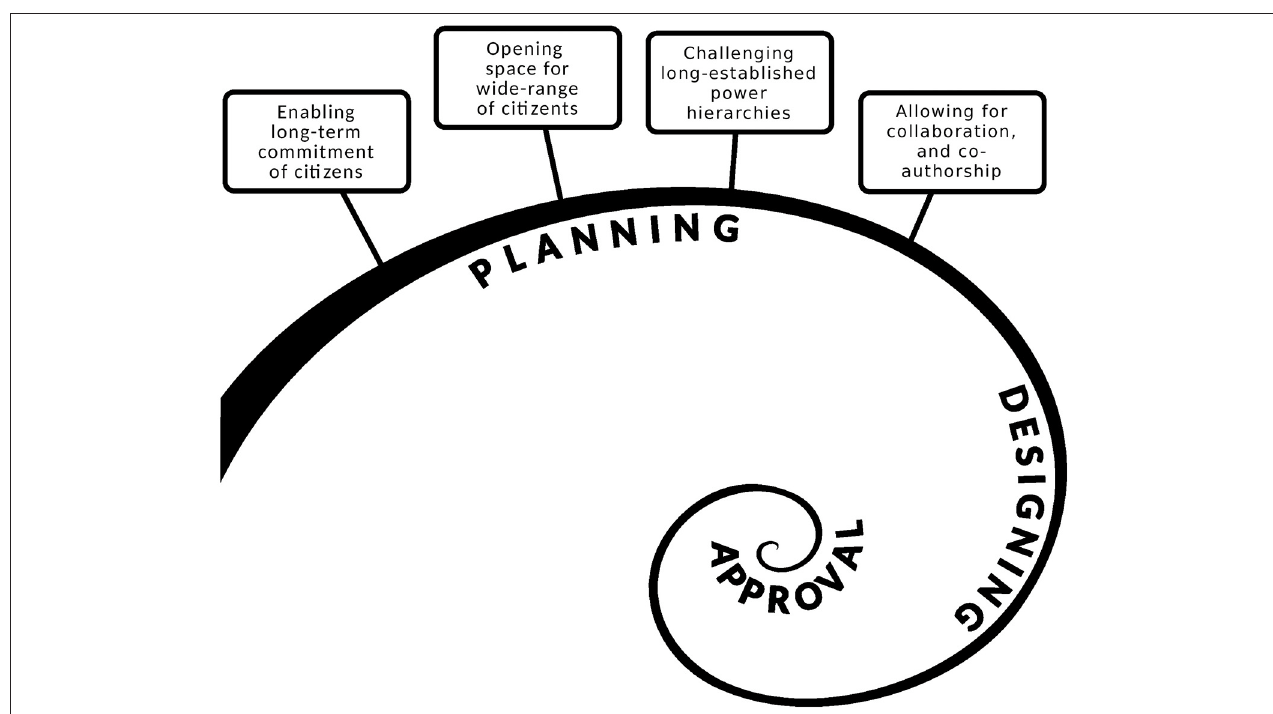
FIGURE 5 | The illustration highlights the main ethical considerations underlying the inclusion of citizens at the planning phase of PUI. As can be seen, the planning phase in emerging research areas (which precedes the project design, submission, and approval), is the most time consuming. Hence, it should be conducted in a cautious and ethically conscious